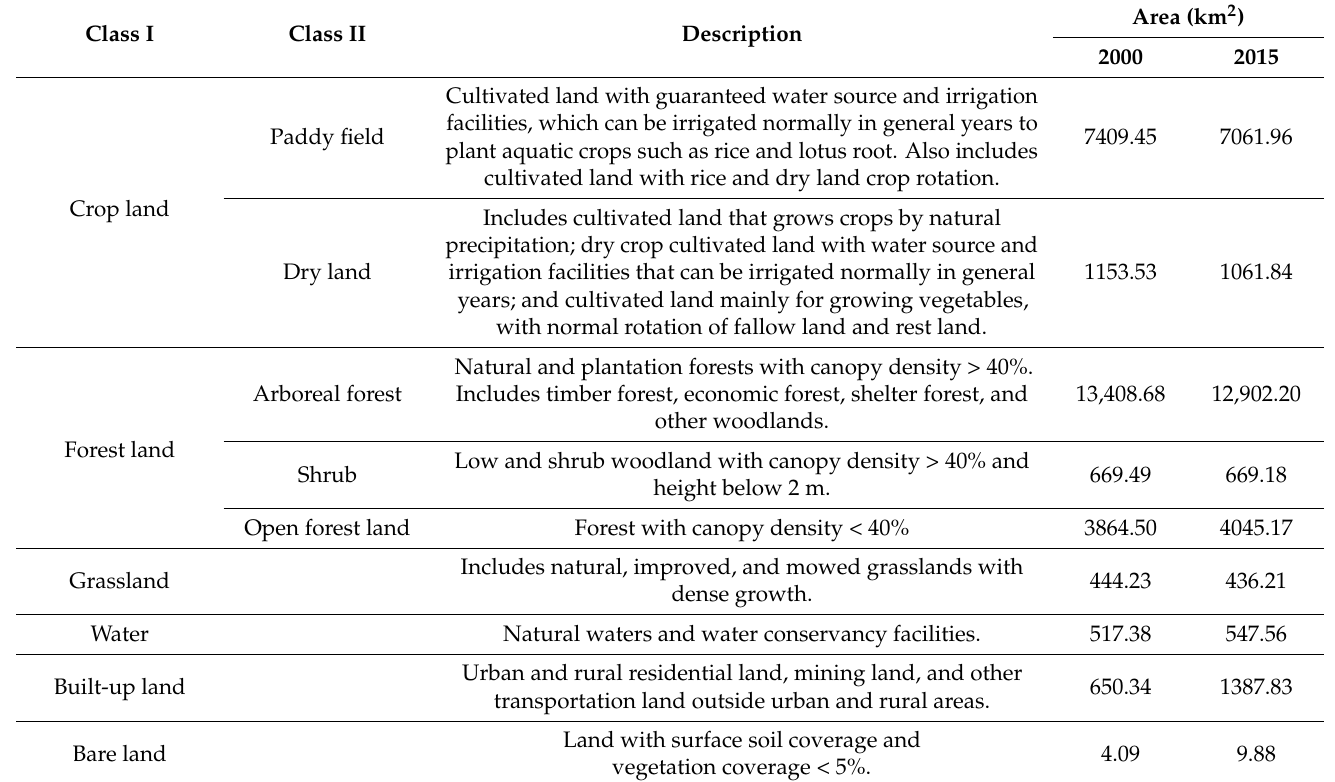
Table 1. The classification, description, and area of the nine different land-use types in this